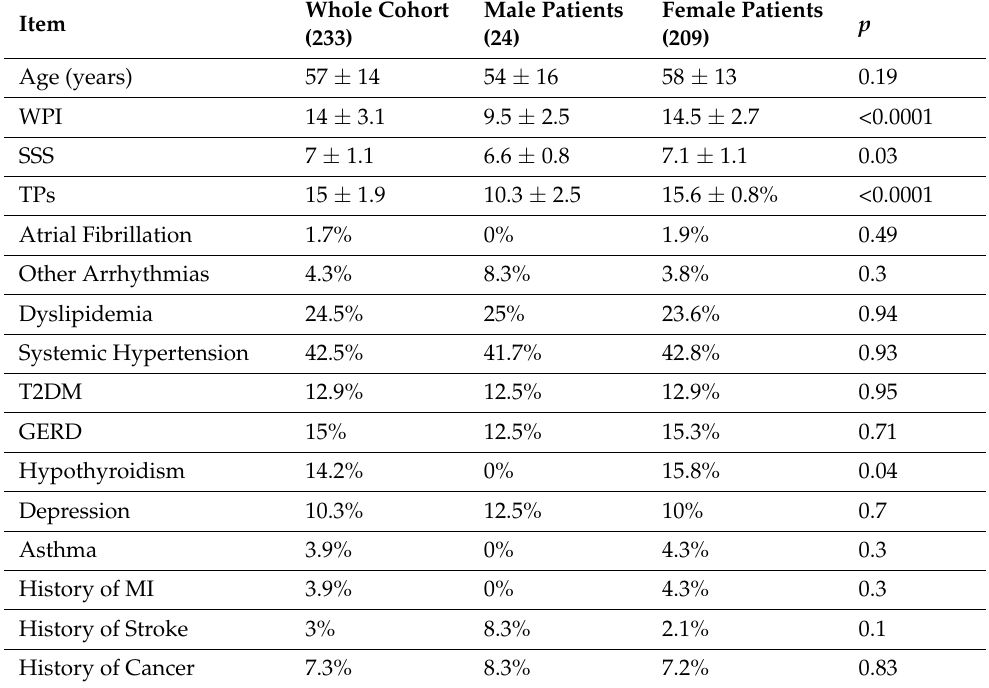
Table 1. General features of Fibromyalgia